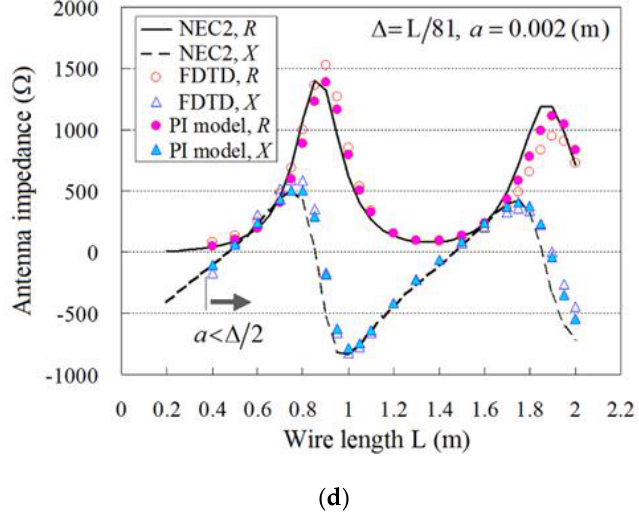
( d ) Z R jX = + , as in Equation (44), obtained via the proposed PI Figure 11. Antenna impedance, Figure 11. Antenna impedance, Z ant = R + jX , as in Equation (44), obtained via the proposed ant PI model, the FDTD method, and NEC2 [60] (reference solution), for λ = 1m and ( a ) ∆ = L /41, model, the FDTD method, and NEC2 [60] (reference solution), for 1 = m and ( a ) /41 L  = , a = 0.001 m, ( b ) ∆ = L /81, a = 0.001 m, ( c ) ∆ = L /41, a = 0.002 m, and ( d ) ∆ = L /81, a = 0.002 m. 0.001 a = m, ( b ) /81 L  = , 0.001 a = m, ( c ) /41 L  = , 0.002 a = m, and ( d ) /81 L  = , 0.002 a = Due to the limitations of the 1/ r approximation model [8,59] on the grid, the extracted results are presented for a < ∆ /2, apart from those derived via NEC2